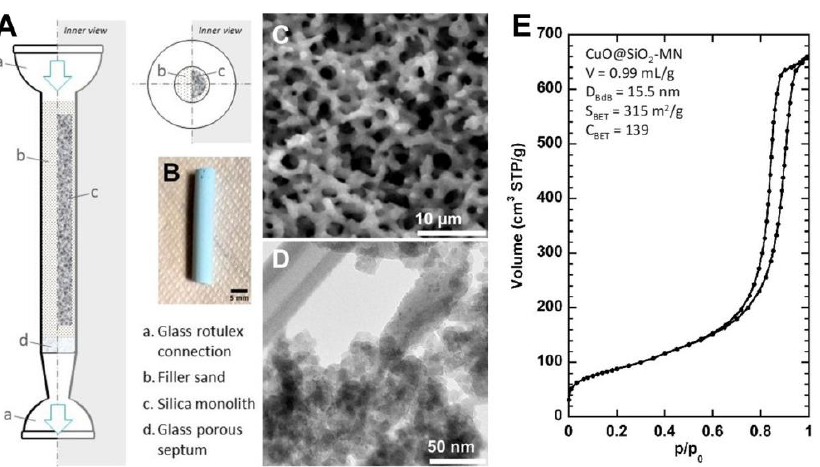
Figure 1. ( A ) Graphical sketch of the set up used for Cu deposition on the silica monolith. ( B ) Picture, ( C ) SEM and ( D ) TEM images and ( E ) N 2 sorption at 77 K of CuO@SiO 2 -MN after calcination at 350 °C (pristine catalyst).